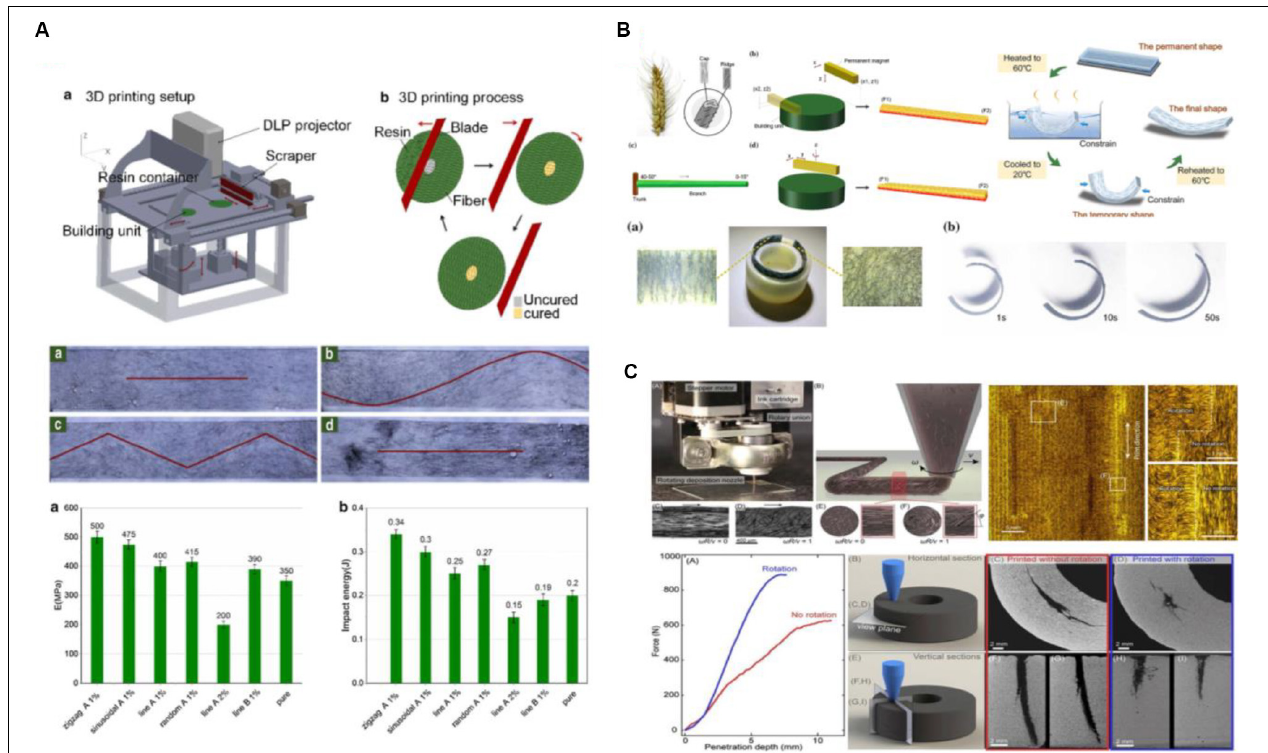
FIGURE 6 | (A) Fiber-reinforced composites, fabricated by a slurry-based stereolithography 3D printing technique (Ren et al., 2019a). Reproduced with the permission of the Korean Society for Precision Engineering 2019. (B) Structural gradient shape memory composites with fibers inspired by the microstructure of wheat awn and softwood branches (Ren et al., 2019b). Reproduced with the permission of Springer Science + Business Media, LLC, part of Springer Nature 2019. (C) Fiber-reinforced composites fabricated by a rotational 3D printing method (Raney et al., 2018). Reproduced with the permission of